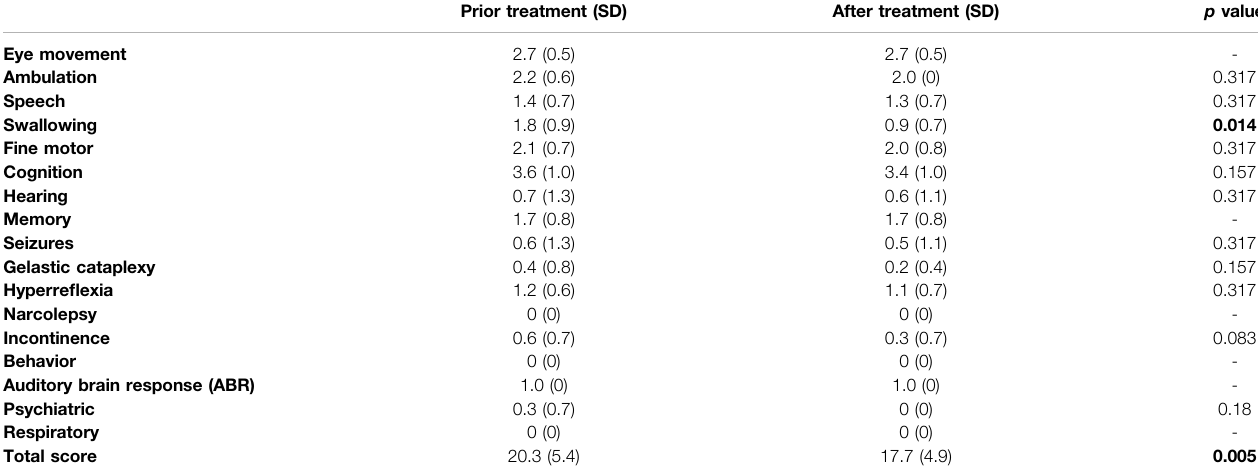
The bold values mean p < 0.05.